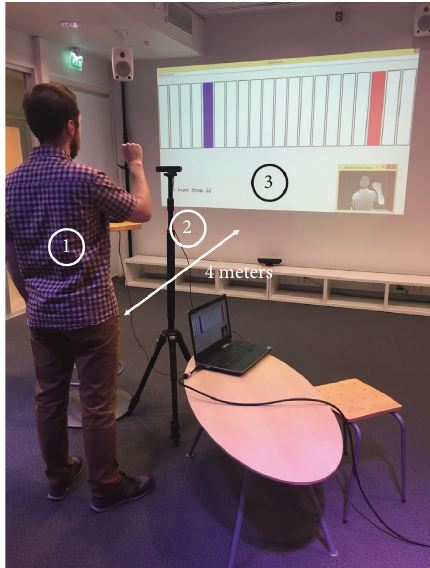
Figure 3: Study setup. (1) User standing in front of the gesture sensor; (2) gesture sensor; (3) large